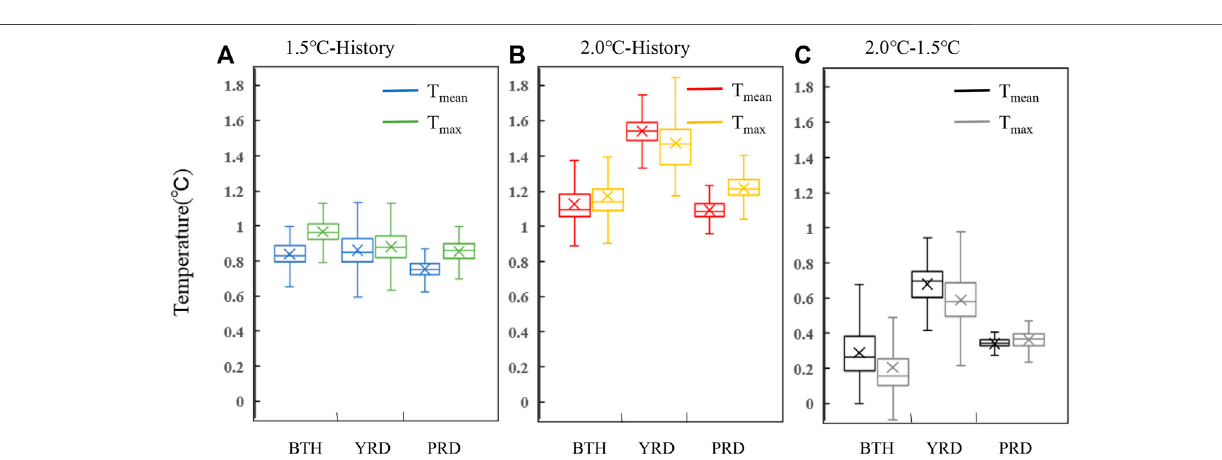
Frontiers in Earth Science |